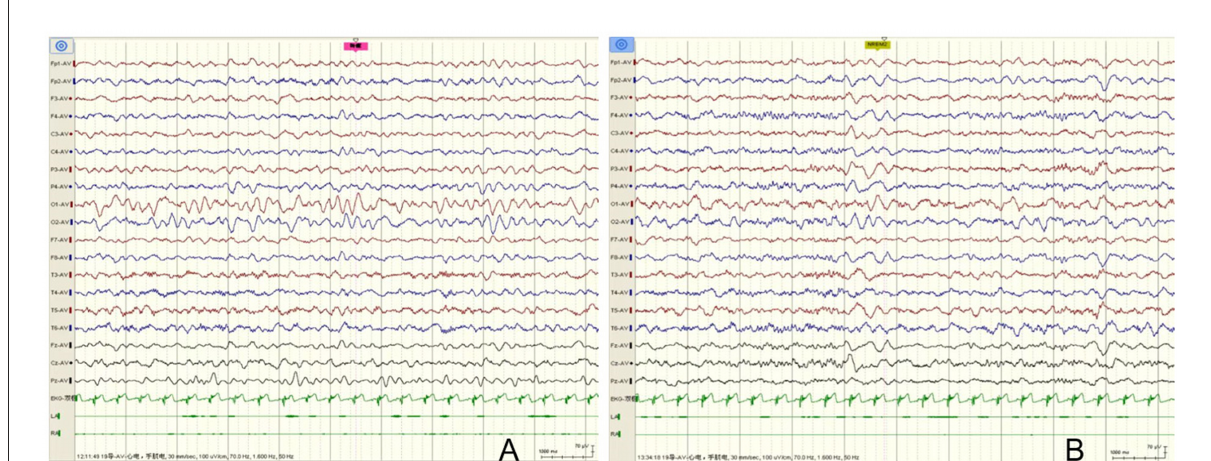
FIGURE1 EEG of the case. (A) EEG showed slow background activity during wakefulness in interictal periods, and no epileptic discharges were observed. (B) No epileptic discharges were observed during sleep